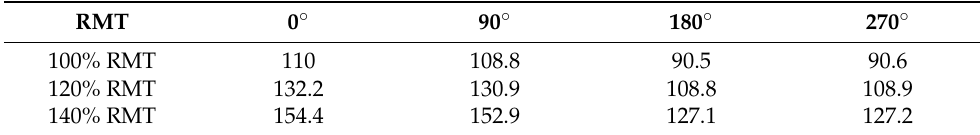
Table 1. E–field values for the 12 conditions explored (measured in V/m).